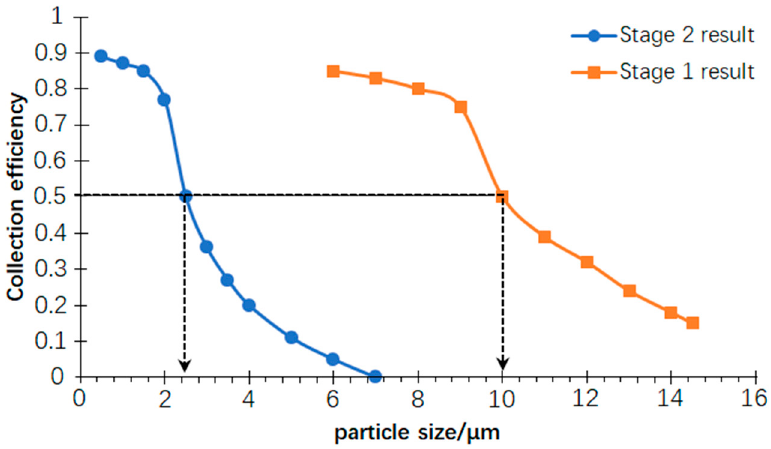
Figure 12. PM air-microfluidic grading chip collection efficiency curve.